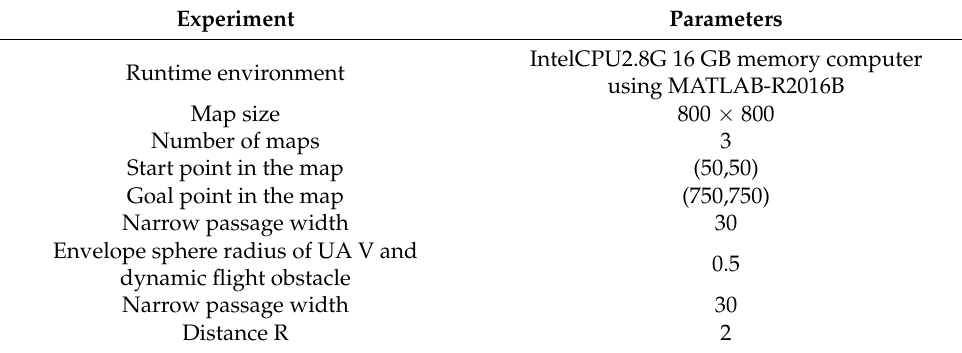
Table 1. The main parameters in the